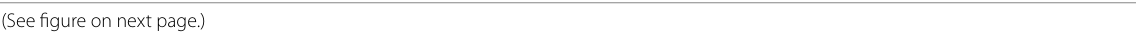
Fig. 5 ROCK1 plays a key role in mediating H 2 O 2 -induced lens epithelial cells apoptosis. a Western blotting confirmation of the siRNA-mediated ROCK1 knockdown. Cells were lysed for western blotting after transfection with si-ROCK1 and si-NC, respectively. β-actin was used as an internal reference. Data are based on three independent experiments. The 100–250 kDa blot was retained by horizontal shear and incubated with the ROCK1 antibody. The 35–50 kDa blot was retained by horizontal shear and incubated with the β-actin antibody. b. Cells transfected